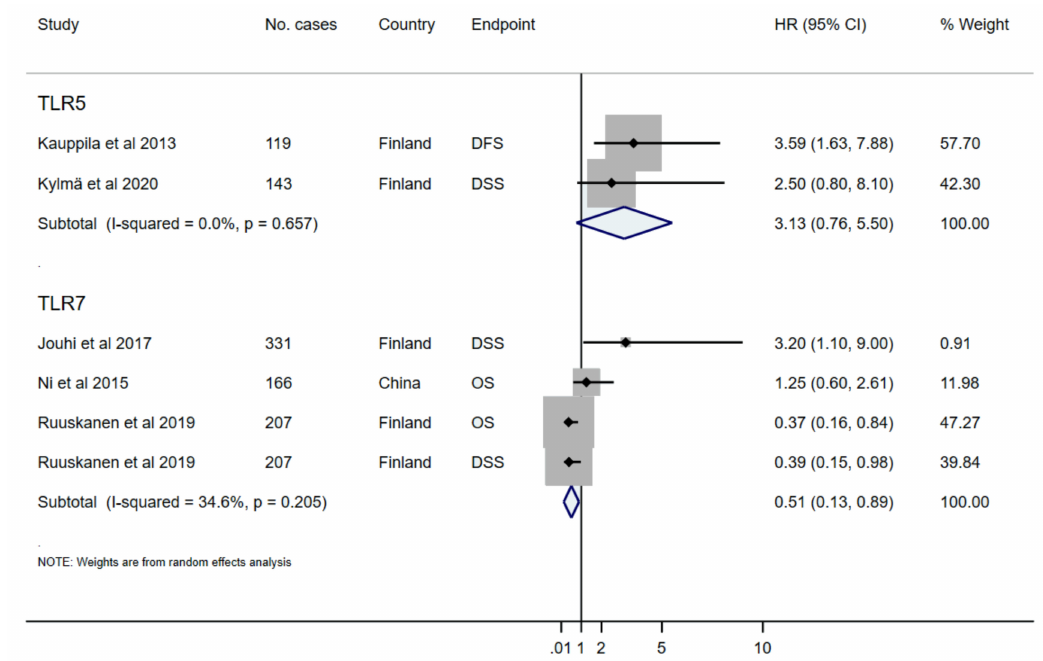
Figure 3. Forest plot demonstrating a subgroup analysis of the association between the studied subtype of toll-like receptor (TLR) and survival outcomes in HNSCC patients (random e ff ects model). HR, hazard ratio; CI, confidence